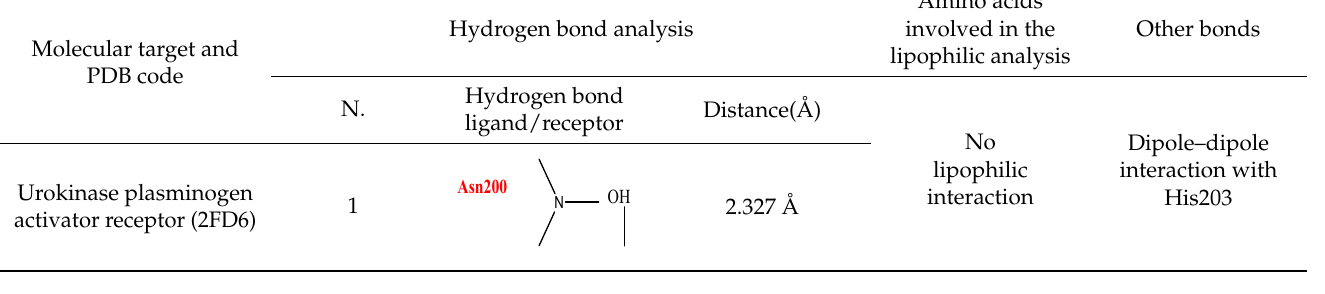
Table 6. Summary of the ligand–receptor interactions for the co-crystallized ligand with their receptor binding site.